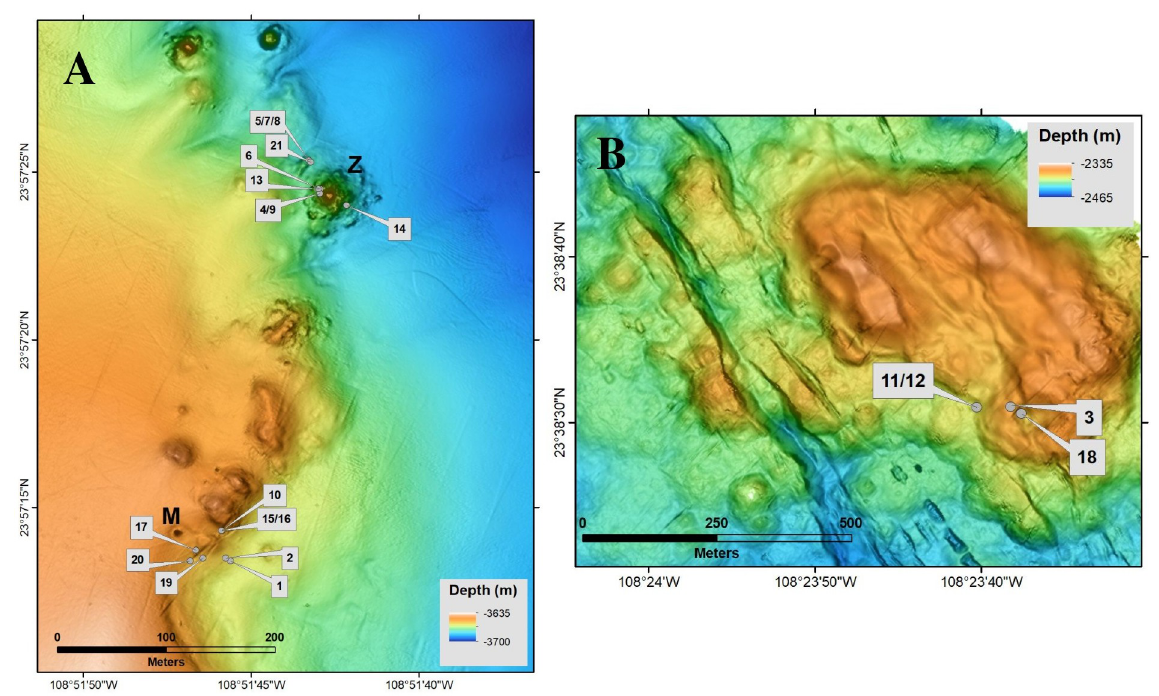
Fig 2. Spatial distribution of the biological samples collected. A) Pescadero Basin (PB) and B) Pescadero Transform Fault (PTF). Numbers identifying individual points are listed in Table 1 as ID numbers.